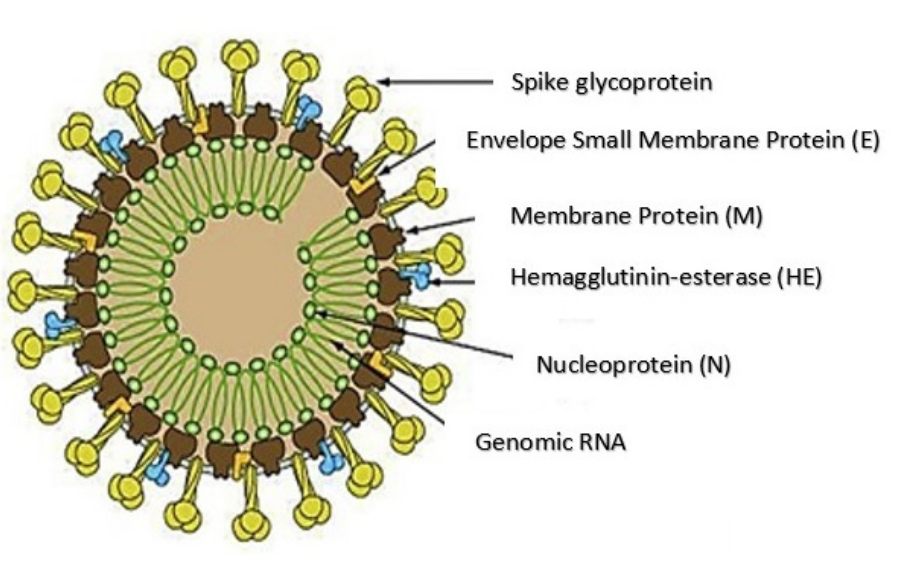
Figure 1. Structure of COVID-19 [Source: http://ruleof6ix.fieldofscience.com/2012/09/a-new- coronavirus-should-youcare html (accessed on 20 June 2020)].